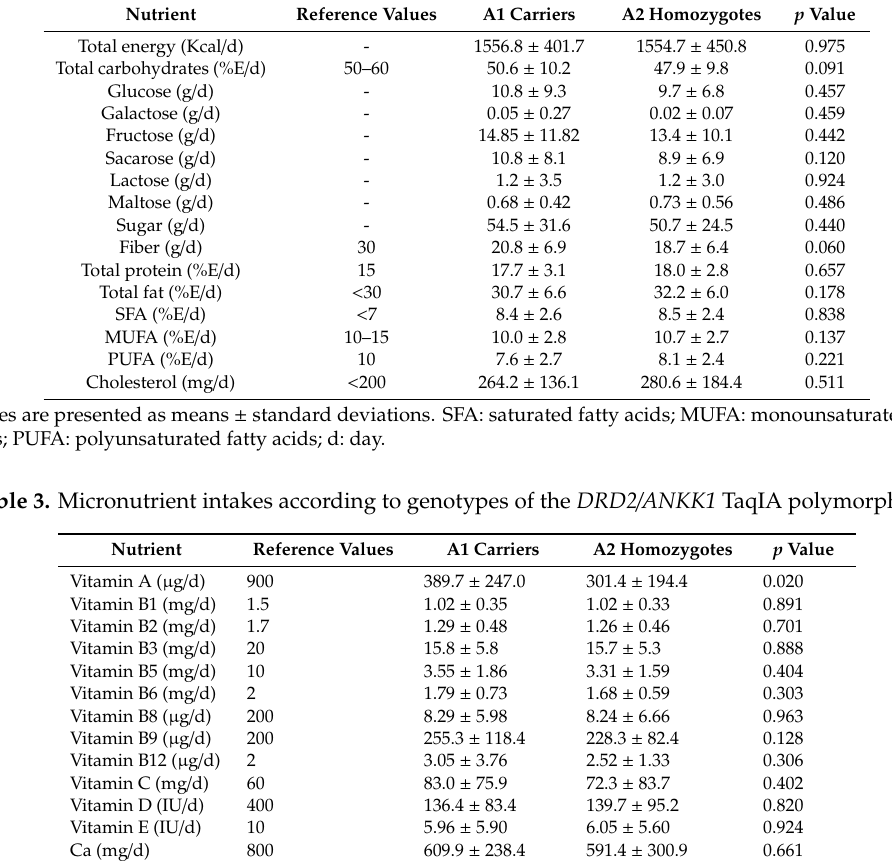
Table 2. Macronutrient intakes according to genotypes of the DRD2 / ANKK1 TaqIA polymorphism.